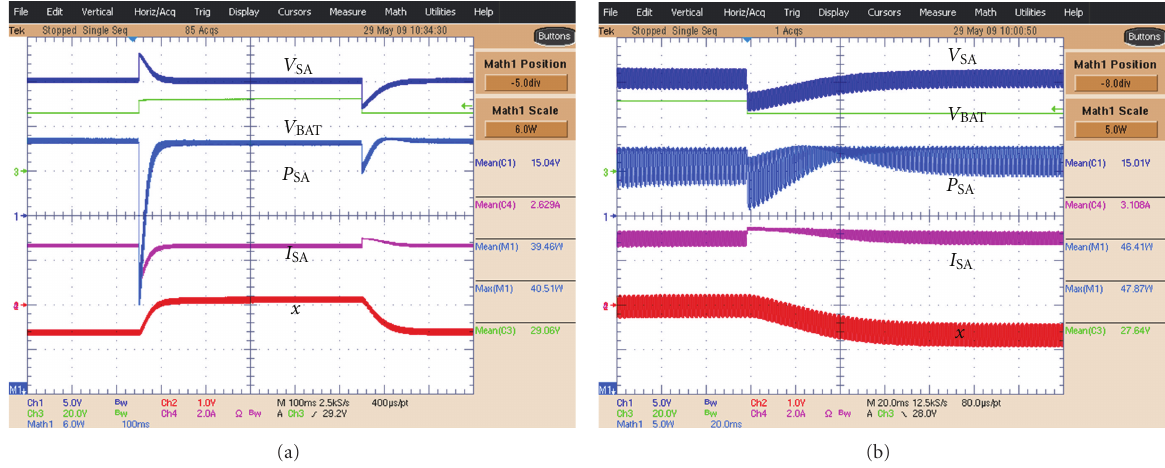
Figure 8: (a) Transient waveform when voltage pulse signal is added to battery voltage. (b) Detail of the transient waveforms during a decrease step of the battery